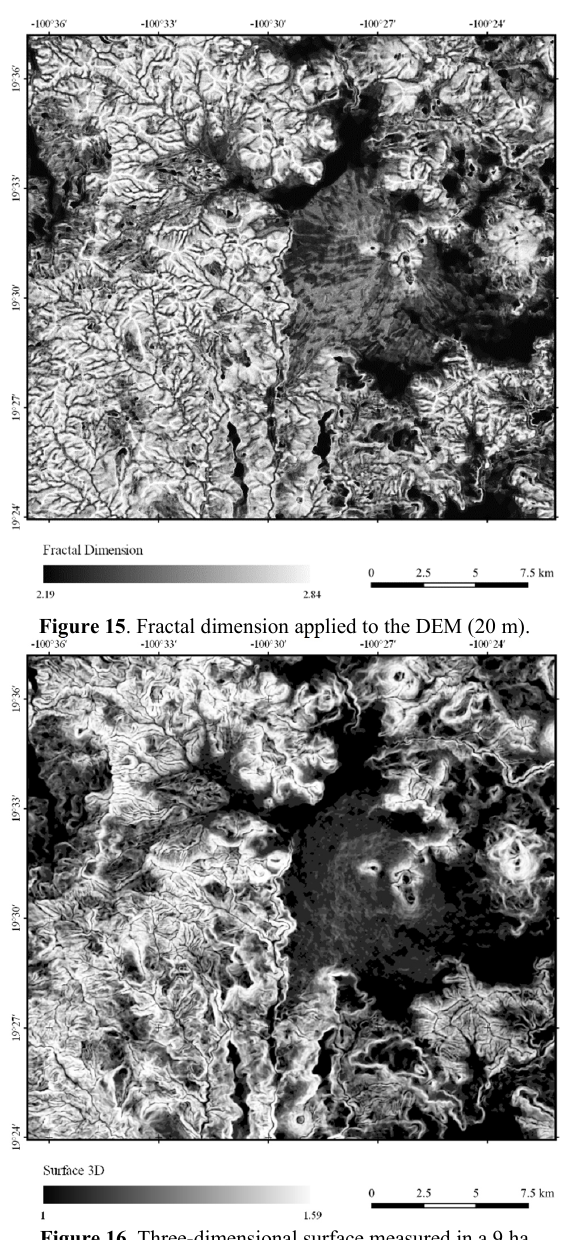
Figure 16 . Three-dimensional surface measured in a 9 ha moving window (20 m resolution